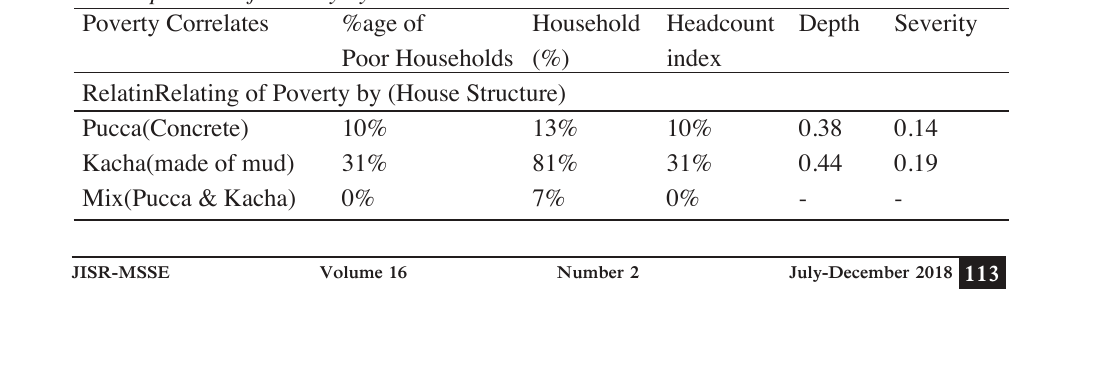
Decomposition of Poverty by its social correlates. Poverty